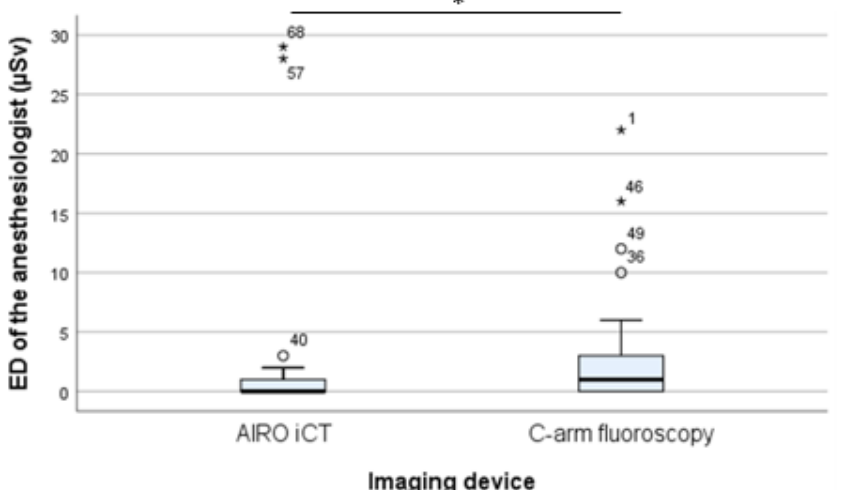
Figure 4. Effective dose (ED) of the anesthesiologist during an MI-PLIF procedure. The ED of the anesthesiologist (µSv) compared between surgeries assisted by iCT ( n = 24) or C-arm fluoroscopy ( n = 42). Extreme values are marked as “ ✩ ” and outliers are marked as “°” on the boxplot. Significance ( p < 0.05) is indicated with “*” above the two boxplots.